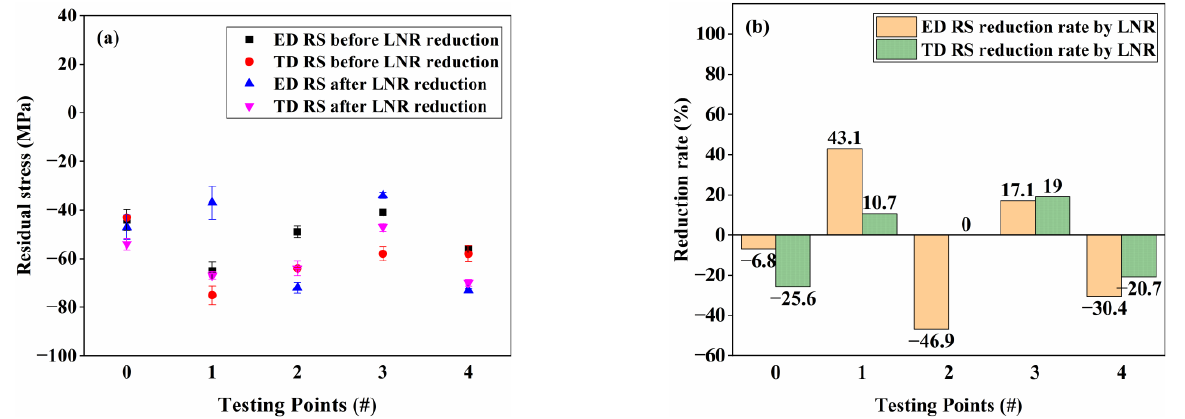
Figure 5. ( a ) ED and TD residual stress and ( b ) relief rate at different points treated by LNR.